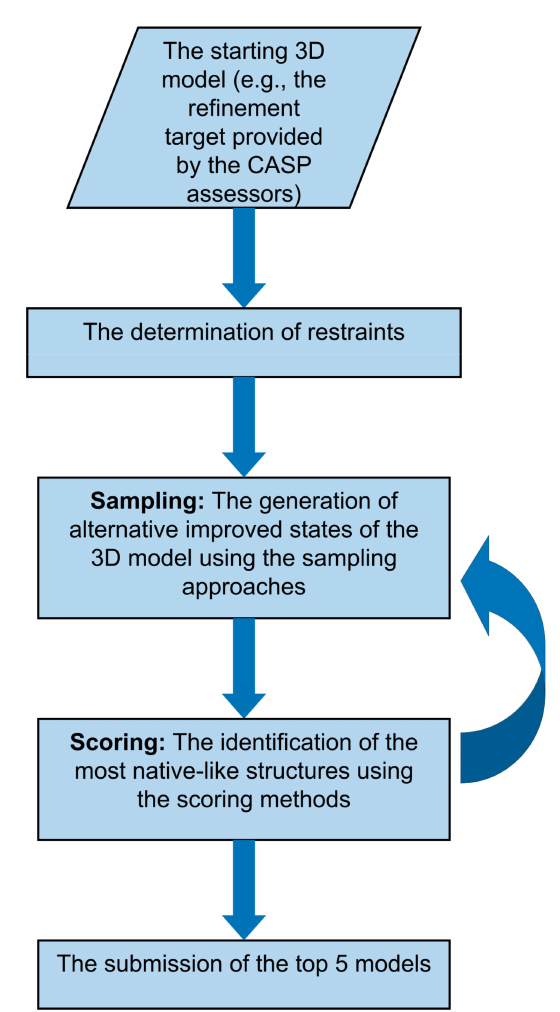
Figure 1. Flowchart outlining the generalized protocol for the refinement of tertiary structure models applied by groups during the Critical Assessment of techniques for Structure Prediction (CASP)